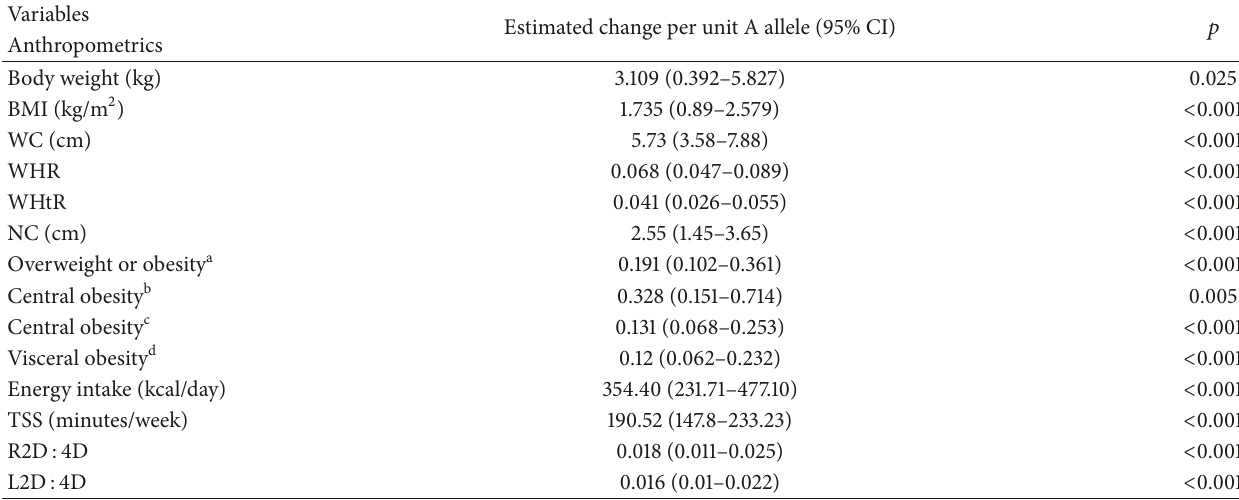
Table 3: Association of FTO rs9939609 genotype with obesity-related